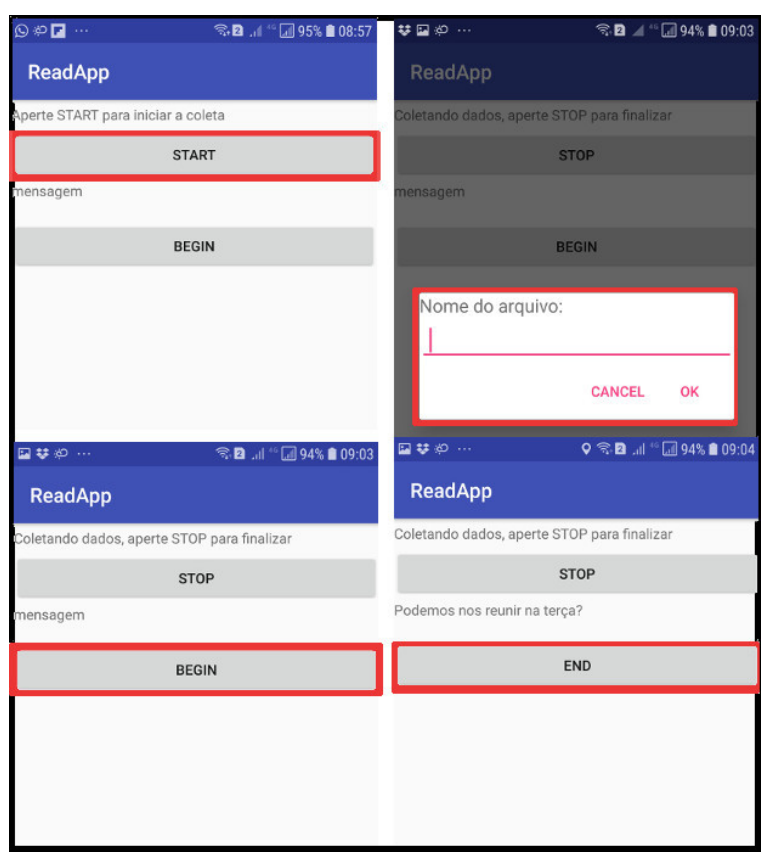
Figure 2. Data Acquisition App: In the first screen ( top right ), the user must enter the name of the log file. The sensors are activated when the user presses the START button. For each message read, the user must press the begin/end buttons to set the sensor data